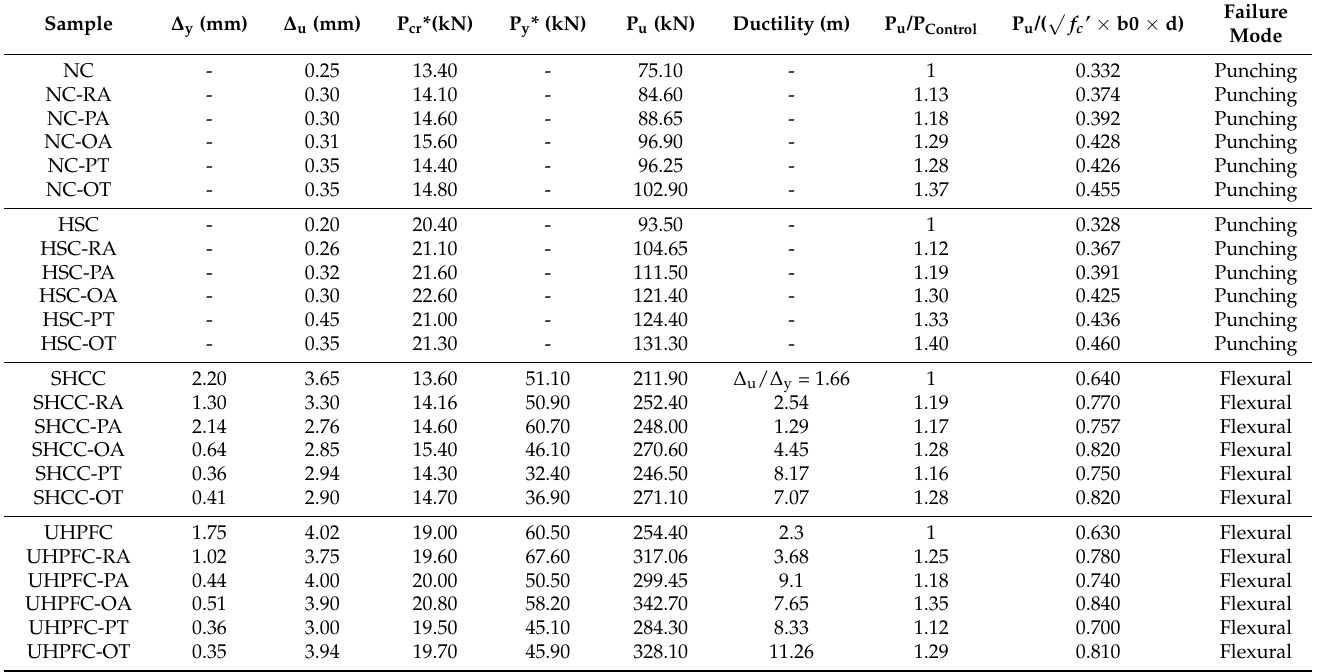
Table 3. Summary of experimental